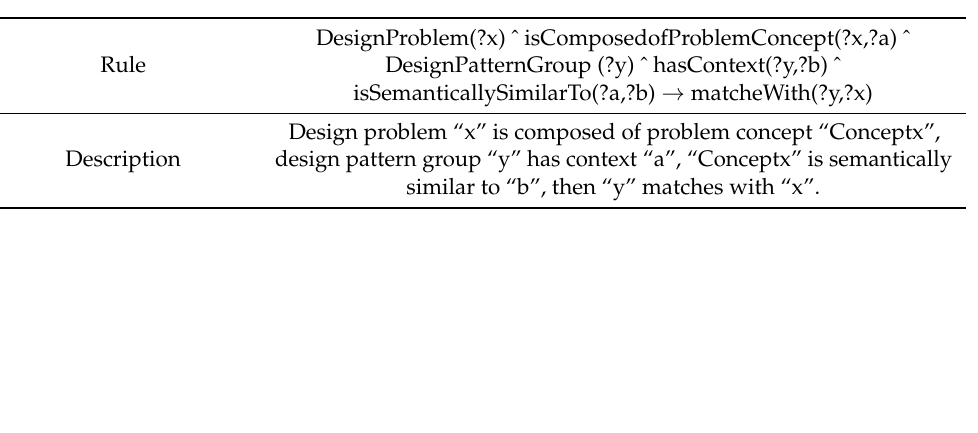
Table 4. A rule example for matching design pattern